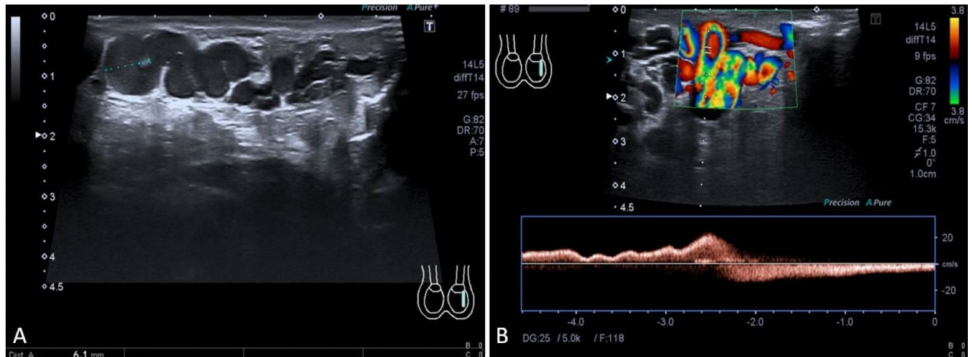
Figure 11. Color Doppler Ultrasound findings of recurrent varicocele after surgery in a 16-year-old male. ( A ) B-mode US image shows high grade ectasia of the left pampiniform plexus extended to the inferior pole of testicle. ( B ) Color Doppler US examination shows persistent flow reversal during the Valsalva